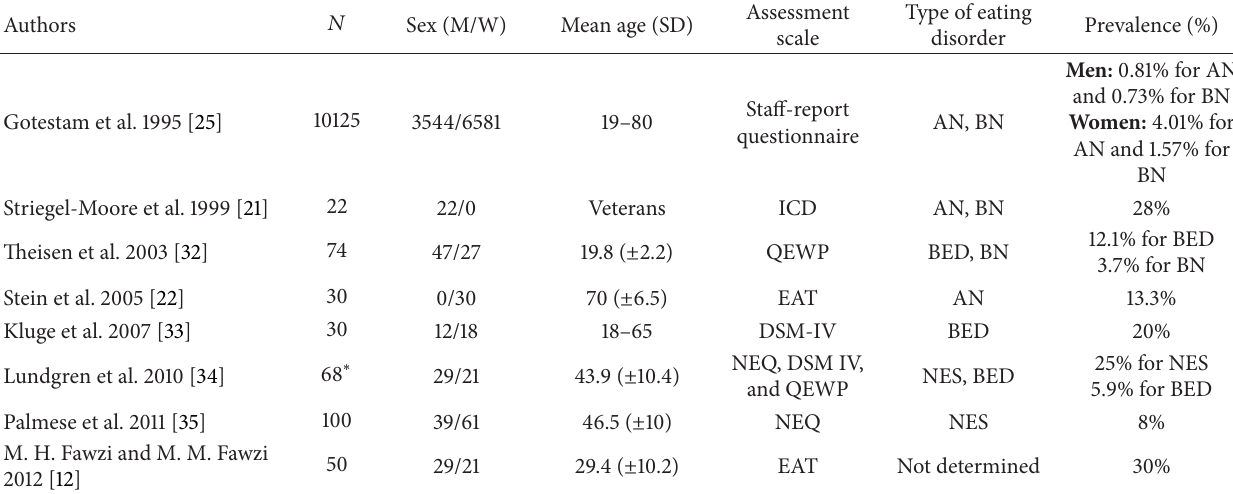
Table 1: Data from descriptive studies evaluating the comorbidity of eating disorders in schizophrenia. Authors 𝑁 Sex (M/W) Mean age (SD) Gotestam et al. 1995 [25] 10125 3544/6581 19–80